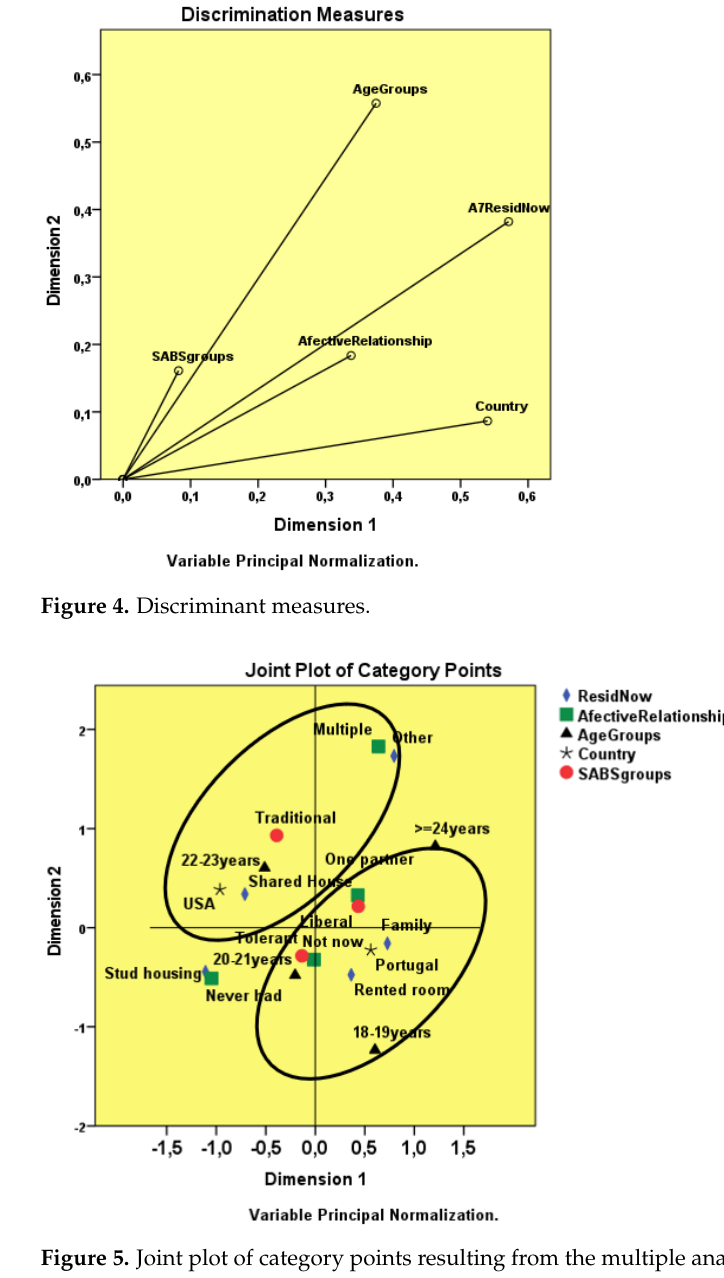
Figure 5. Joint plot of category points resulting from the multiple analysis.